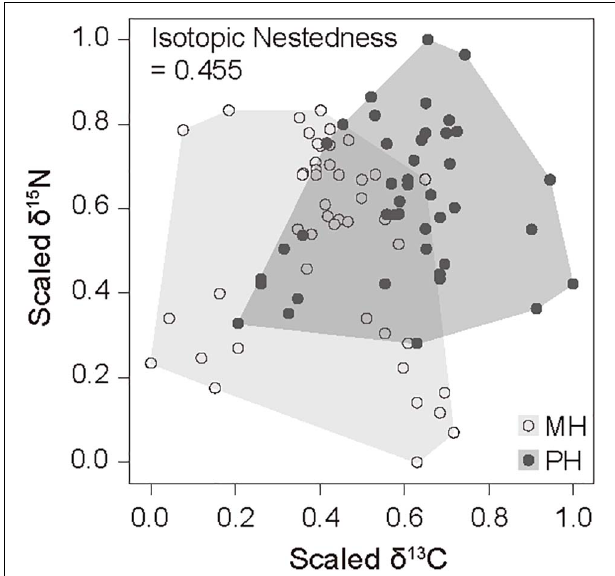
FIGURE 2 | Isotope overlap metrics scatterplot and associated convex hull for the δ 13 C and δ 15 N values of consumers caught at the MH and PH sites. Based on a convex hull area, isotopic niches between consumer groups of both sites were compared by their overlap (position and area) in the isotopic space by calculating isotopic